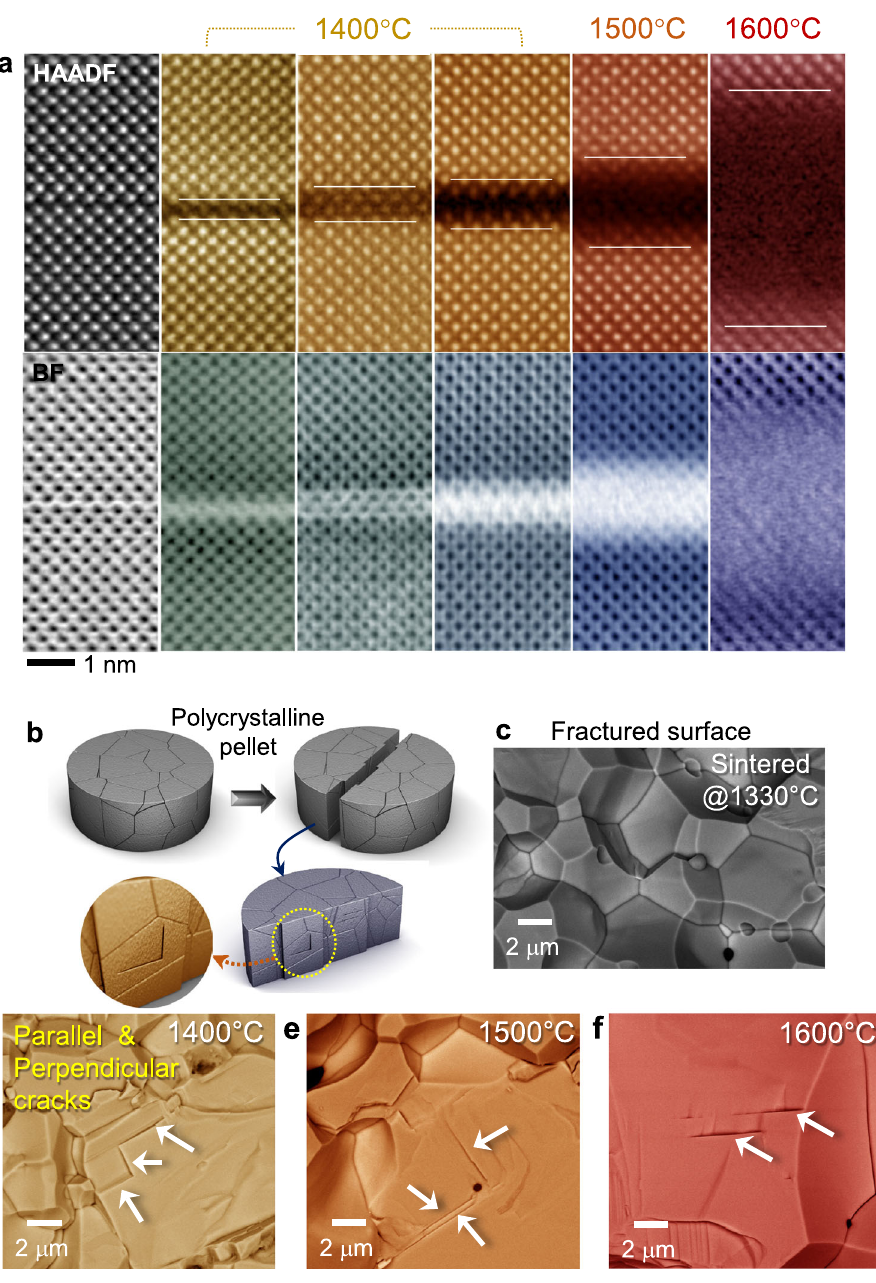
Fig. 3 | Observation ofpremelting atthe faults.a The loss ofcolumn contrast by meltingiseasilyobservableinbothHAADFandBFimagingmodes.Asdenotedbya pairofwhitelinesineachHAADFimage,theamorphouslayerbecomesthickerwith increasing the post-annealing temperature. b A schematic illustration depicts the observationofthefracturedsurfacebySEM. c Beforepremeltingatthefaultsinthe